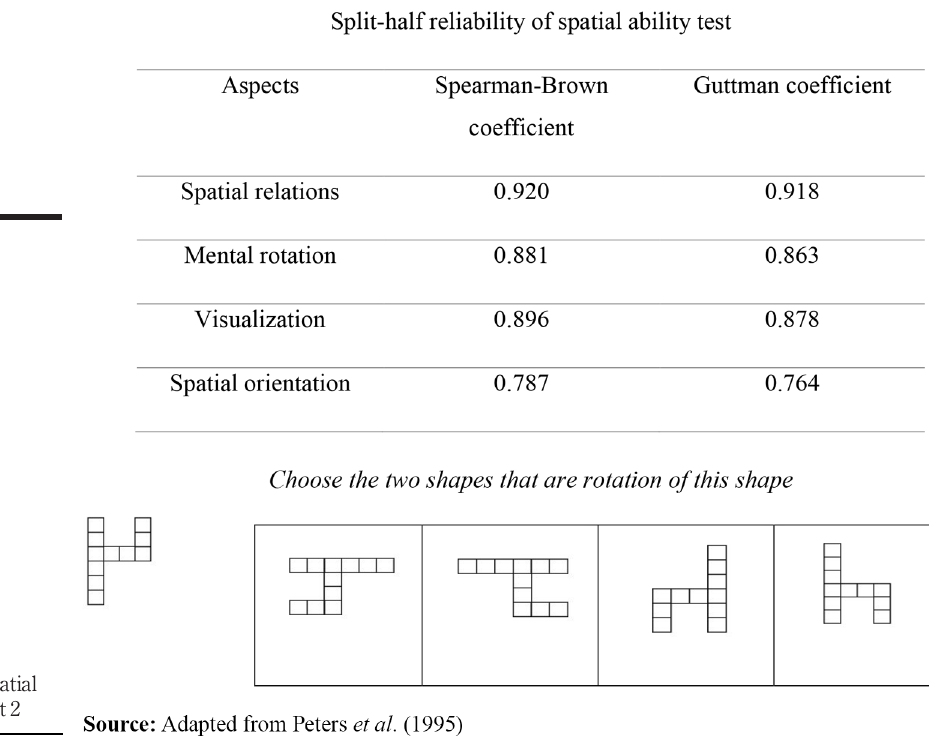
Figure 6. Example of Spatial ability test part